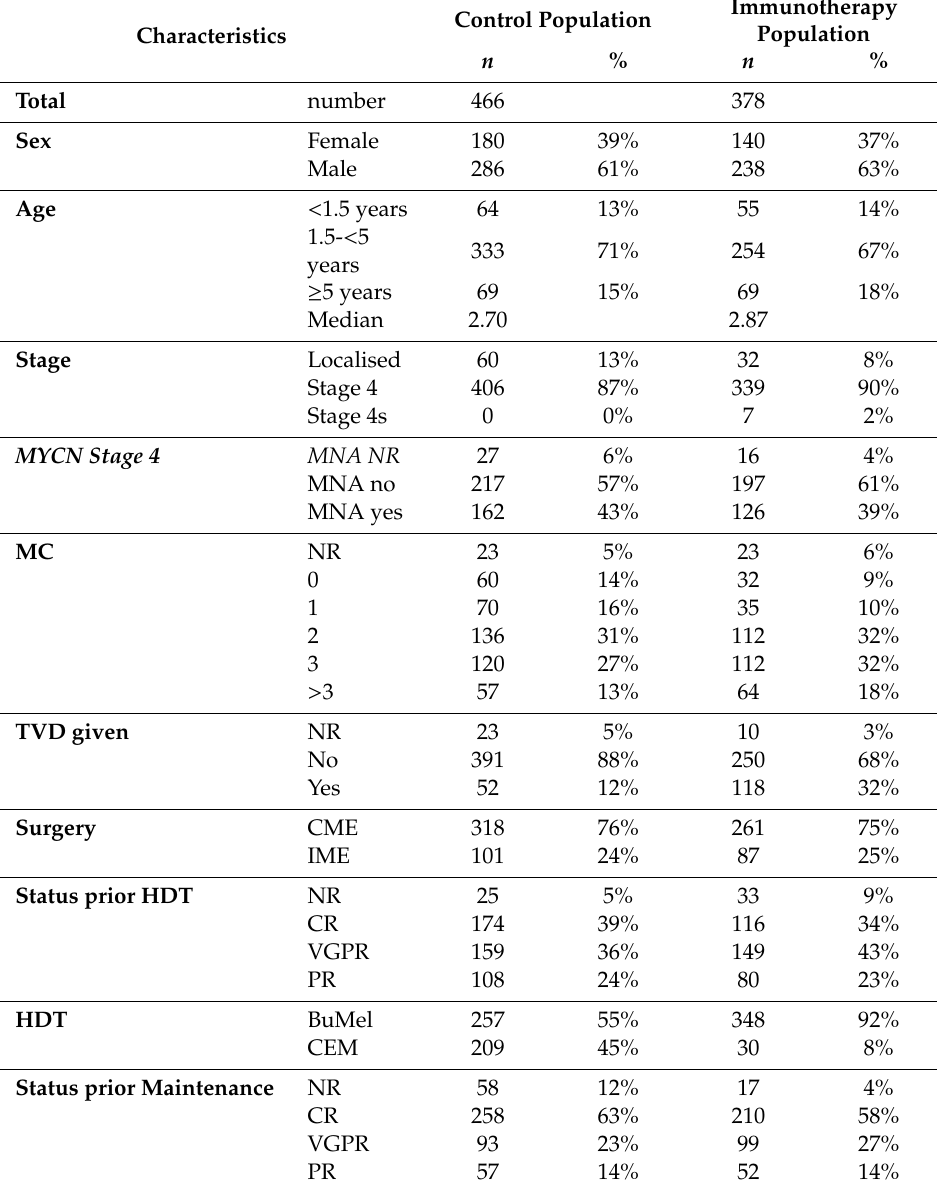
Table 1. Characteristics of the control and immunotherapy populations. N = number; % = percentage; MNA = MYCN amplification; no = not present and yes = present; MC = metastatic compartments; TVD = topotecan, vincristine and doxorubicin; HDT = high-dose chemotherapy; BuMel = high-dose chemotherapy with busulfan and melphalan; CEM = high-dose chemotherapy with carboplatin, etoposide and melphalan; NR = not reported; CR = complete remission; VGPR = very good partial remission; PR = partial remission; CME = complete macroscopic excision and IME = incomplete macroscopic